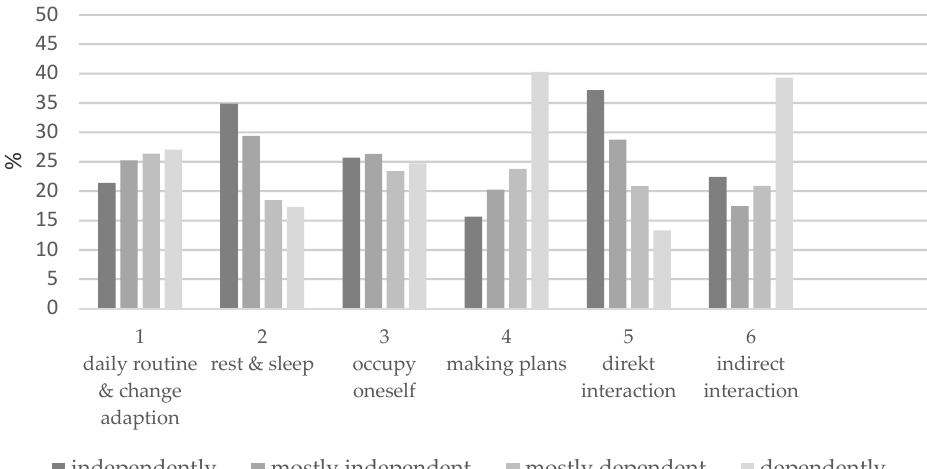
Figure 2. Residents’ abilities to organize everyday life and maintain social Figure 2 . Residents’ abilities to organize everyday life and maintain social contacts.